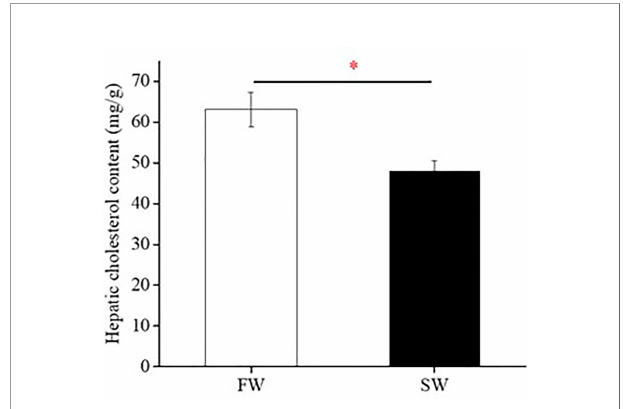
FIGURE 1 | Hepatic cholesterol content of fresh water (FW)- and seawater (SW)-acclimated Indian medaka. Values are mean ± S.E.M. (N = 6). Student ’ s t-test, *p <